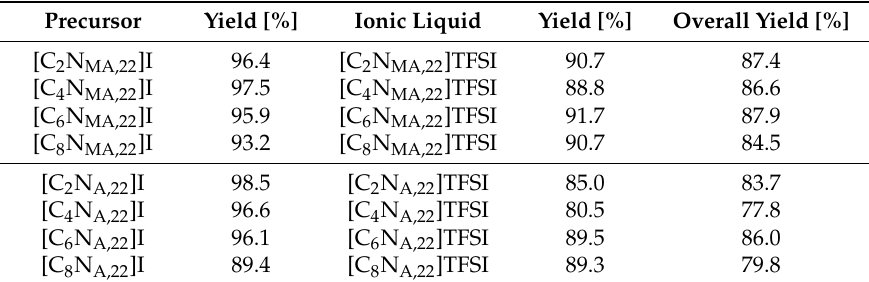
Table 2. Particular yields of all reaction steps and resulting overall yields for the